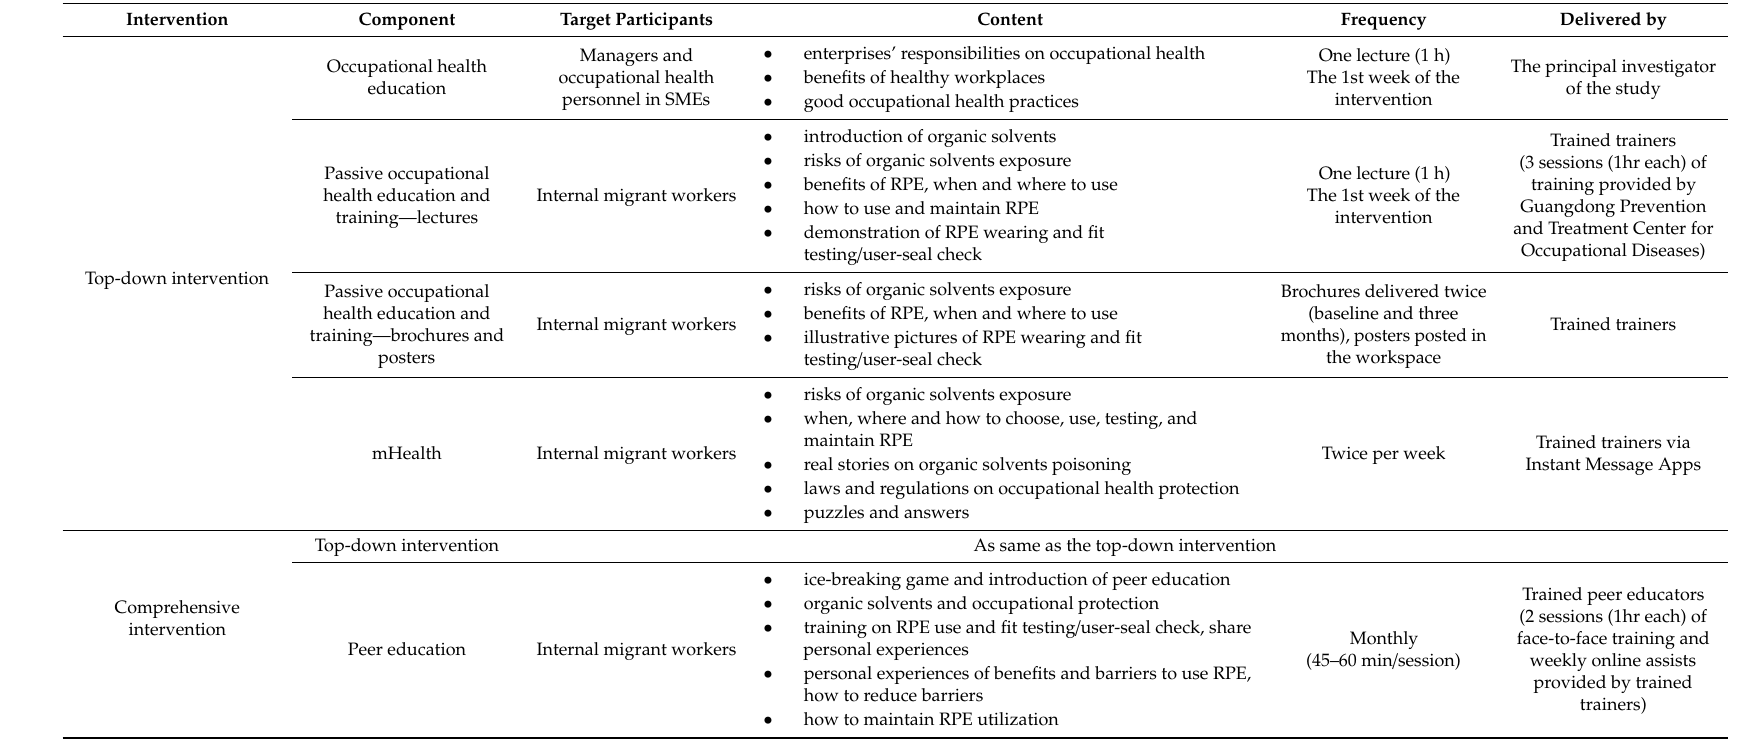
Table 1. Intervention procedures during a six-month